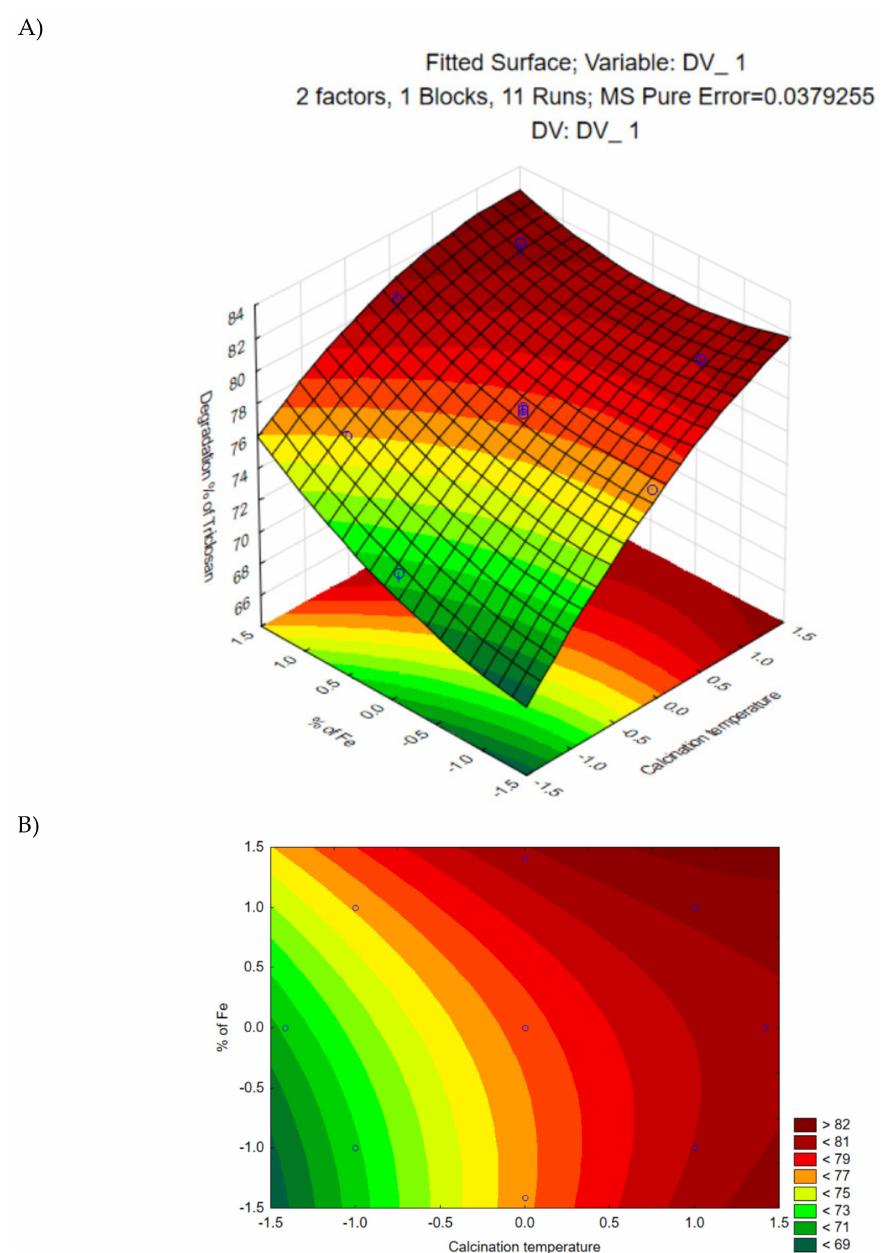
Figure 9. ( A ) Response surface plot for degradation TCS by Nb 2 O 5 versus wt % Fe and Temperature Calcination. ( B ) Surface contour obtained in the experimental design. (Coded variable Table